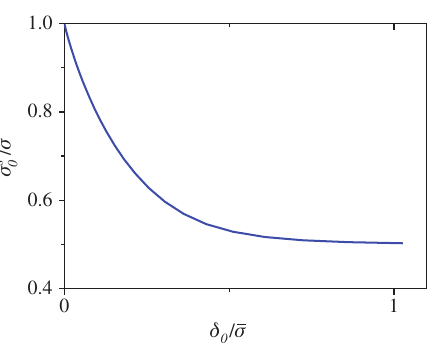
Figure 6 Dependence of the yield stress σ critical shear